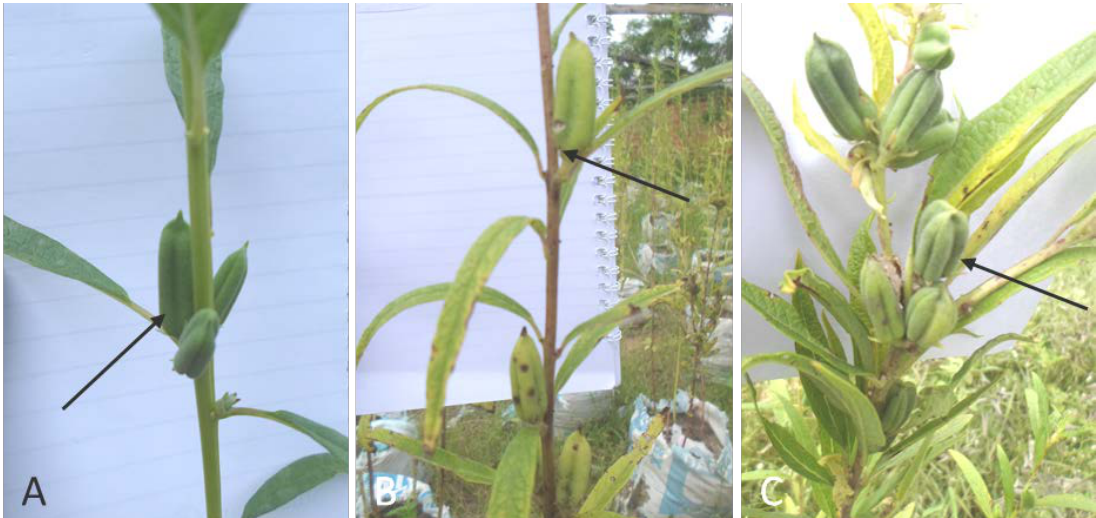
Fig. 2. Mutants from NCRIBEN-01M exposed to 350 Gy and the control (untreated); A = a mutants with multiple capsules at leaf axil and bicarpellate; B = control with single capsule at leaf axil and bicarpellate; C = a mutants with multiple capsules at leaf axil and tricarpellate